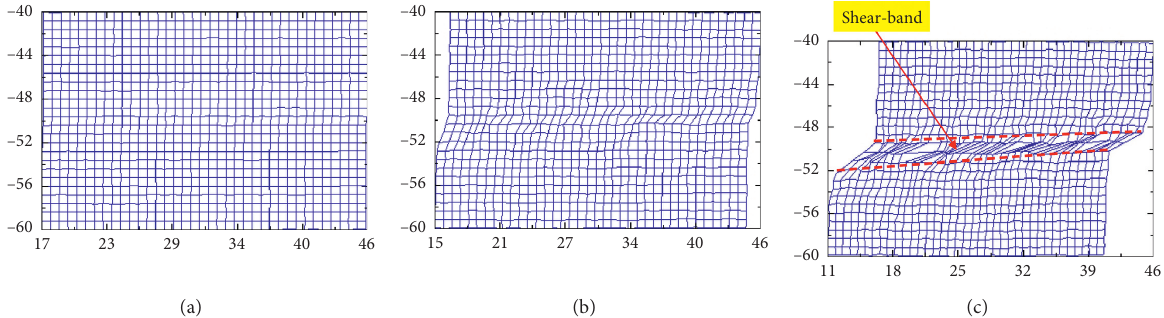
Figure 5: Grid graphs for the deformation of calcareous sand during shearing: (a) S � 1.0 mm; (b) S � 3.0mm; (c) S � 7.8mm (note: the units of horizontal and vertical coordinates in the figure are pixel